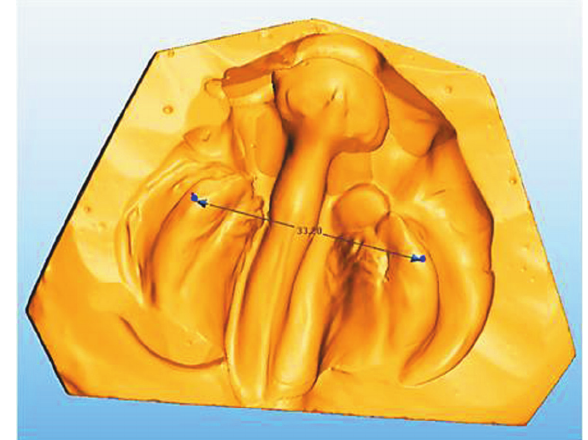
Figure 5- Screen of the computer showing the digitzed cast and the respective